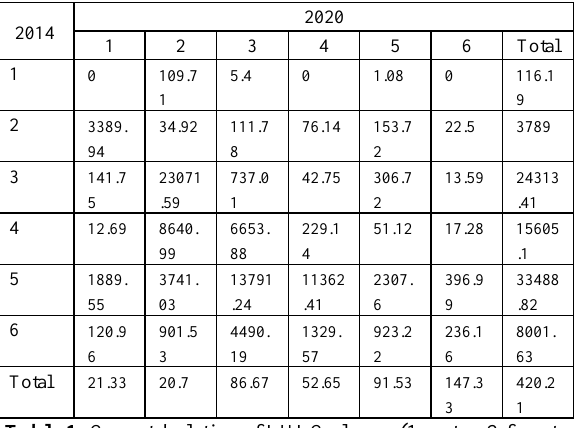
Table 1. Cross tabulation of LULC classes (1-water, 2-forest, 3-grassland, 4-open, 5-agriculture, 6-builtup) of Pantabangan- Carranglan Watershed between 2014 and 2020.